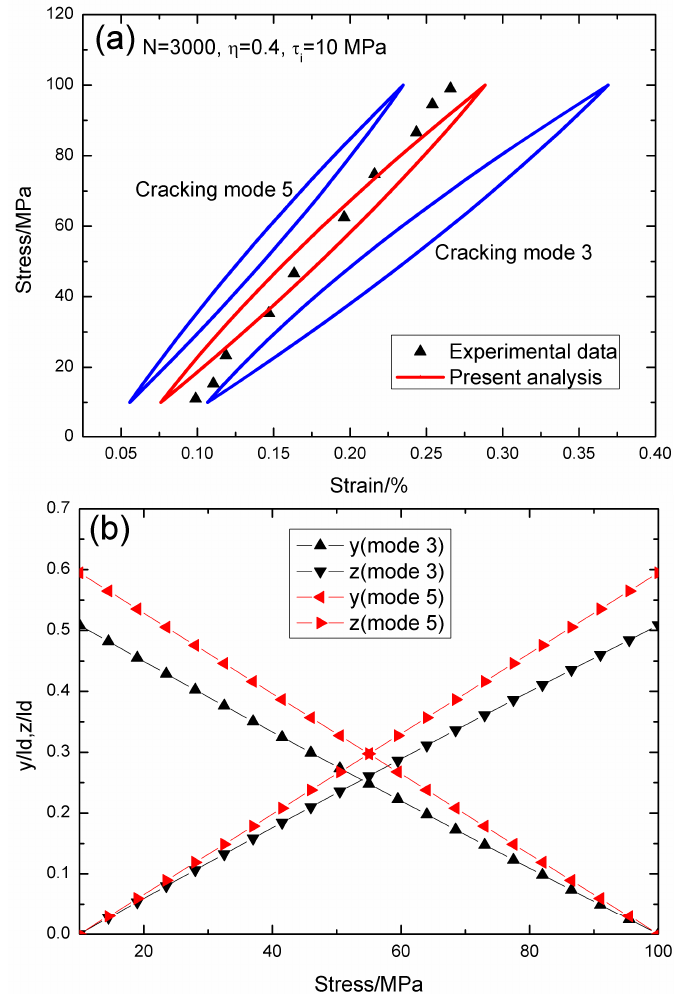
Figure 9. ( a ) The theoretical and experimental hysteresis loops; and ( b ) the interface slip lengths, i.e. , y / l d and z / l d , of matrix cracking modes 3 and 5 of 2D woven SiC/SiC composite under σ max = 100 MPa at 1000 °C in steam and a loading frequency of 1.0 Hz when N =